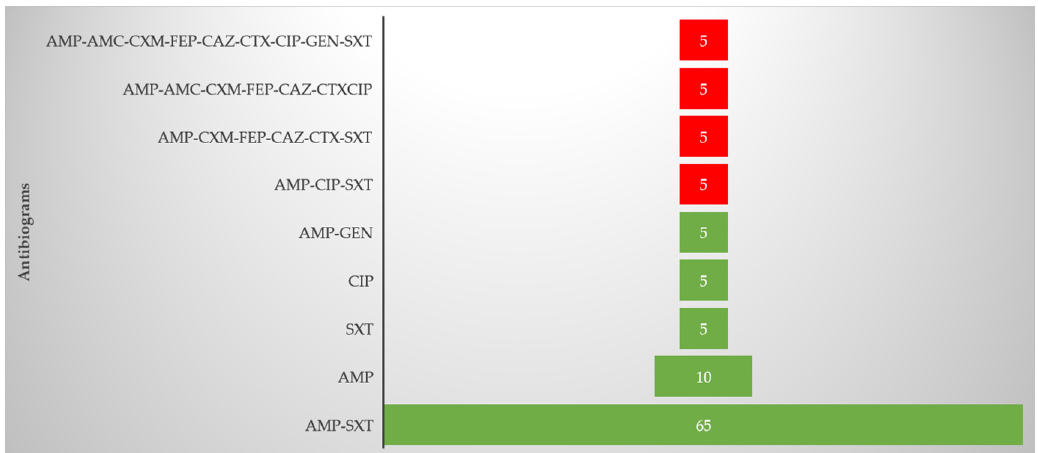
Figure 2. Antibiograms of the resistant isolates. Numbers represent percentage occurrence. The red color denotes the multidrug-resistant isolates. AMP = Ampicillin, SXT = Trimethoprim-sulfamethoxazole, CIP = Ciprofloxacin, CXM = Cefuroxime, FEP = Cefepime, CAZ = Ceftazidime, CTX = Cefotaxime, AMC = Amoxicillin/clavulanate, GEN = Gentamycin.